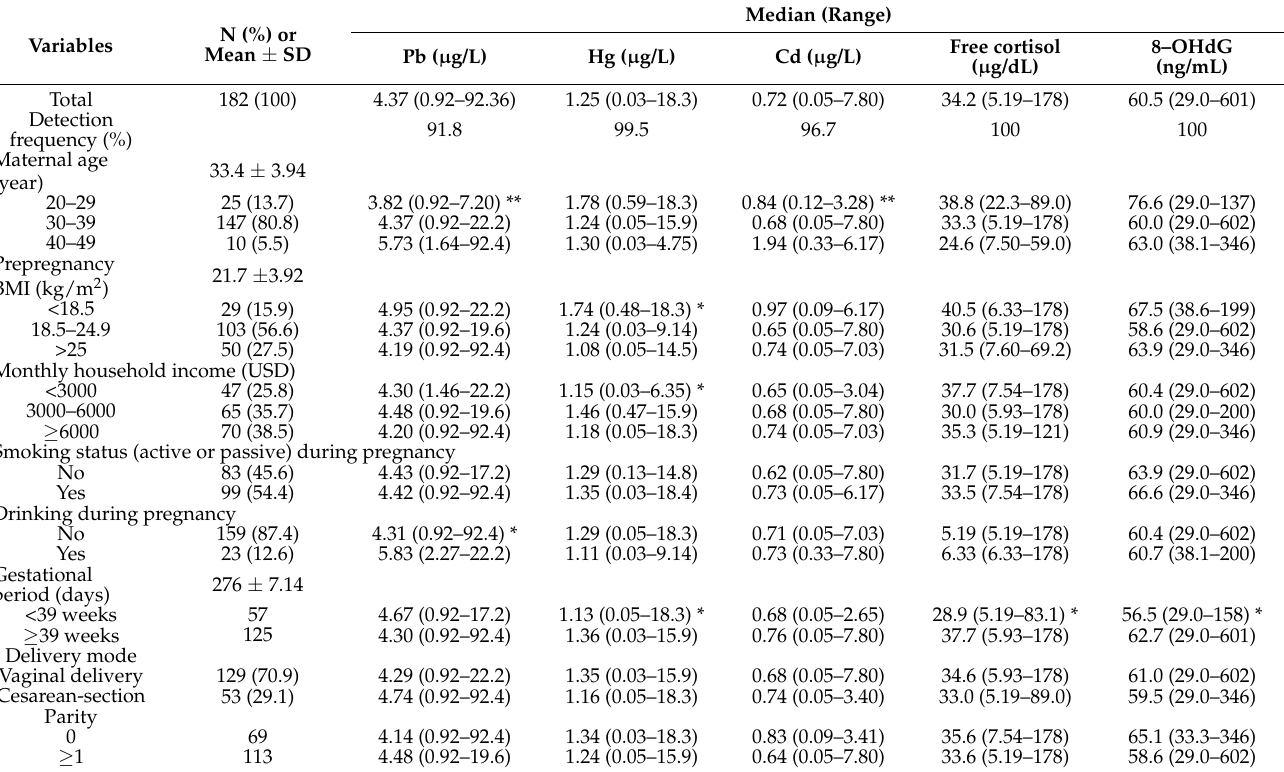
Table 1. Demographic characteristics of the study population (n = 182) and their urinary specific gravity (SG)-adjusted concentrations of Pb, Hg, Cd, free cortisol, and